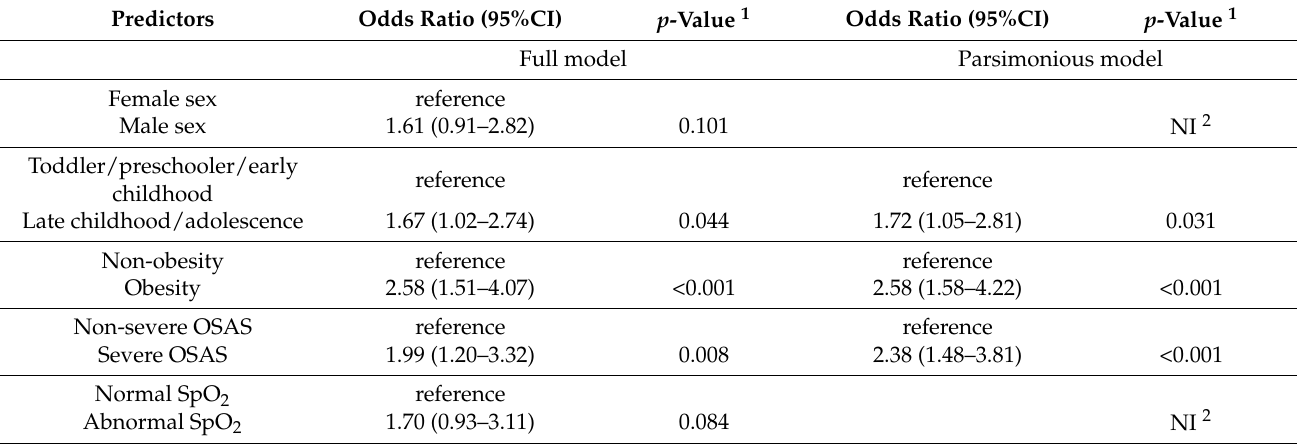
Table 4. Multivariate logistic regression analyses for predicting pediatric hypertension in the overall